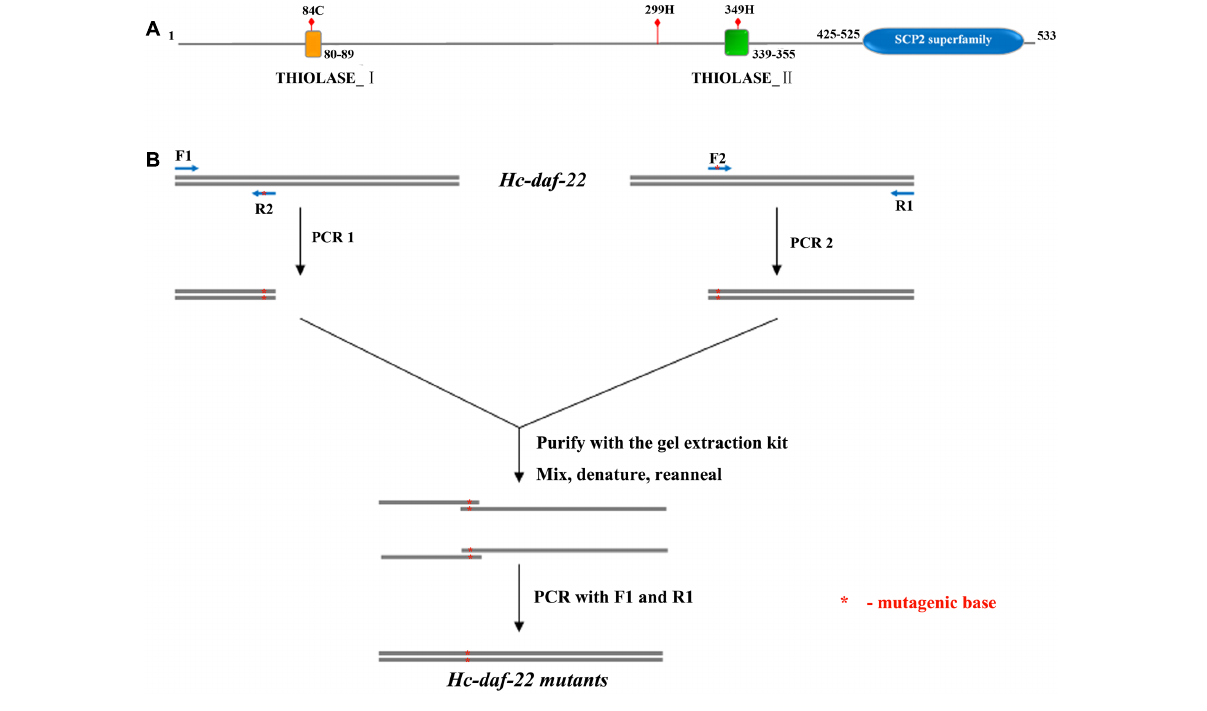
Frontiers in Microbiology |